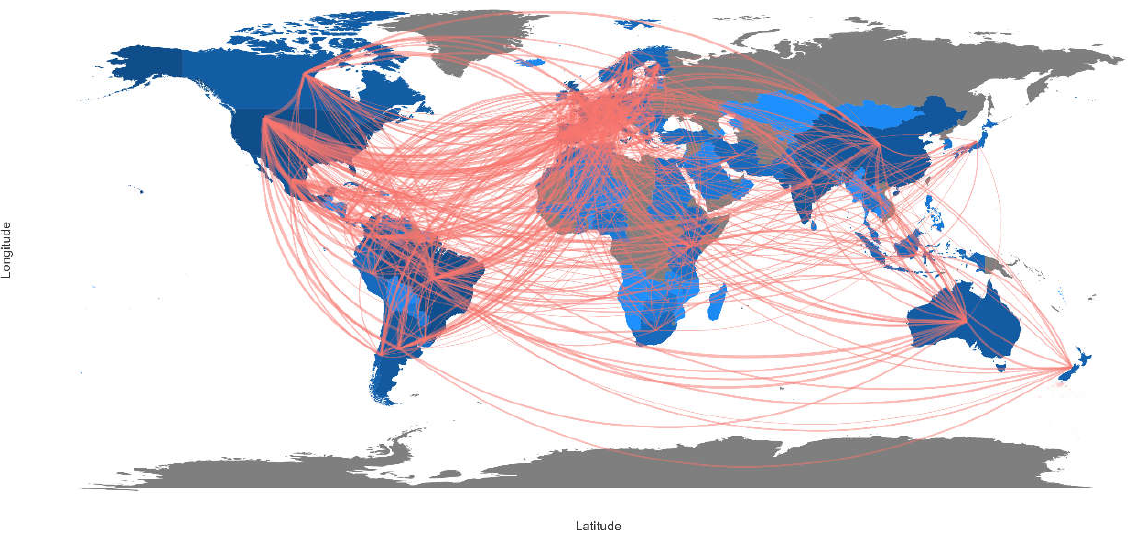
Figure 5. Collaborative networks in silvopastoral systems studies around the world from 1983 to 2022.